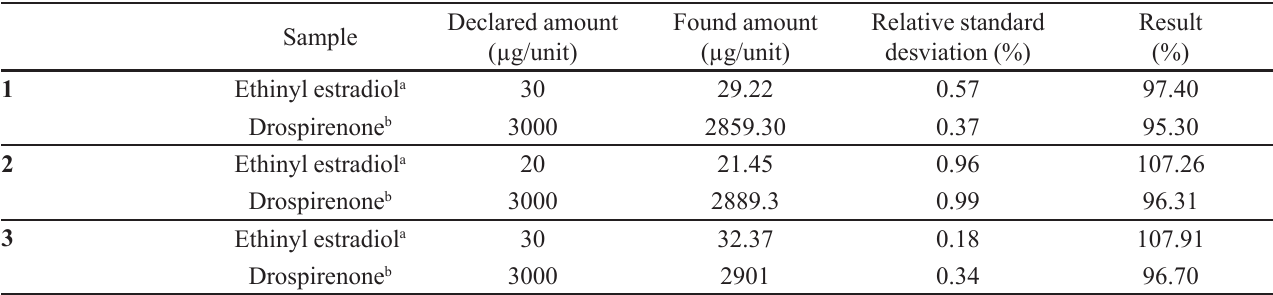
TABLE III - Statistical representation of the data obtained in the analysis of commercial available samples (1, 2 and 3) using the proposed HPLC